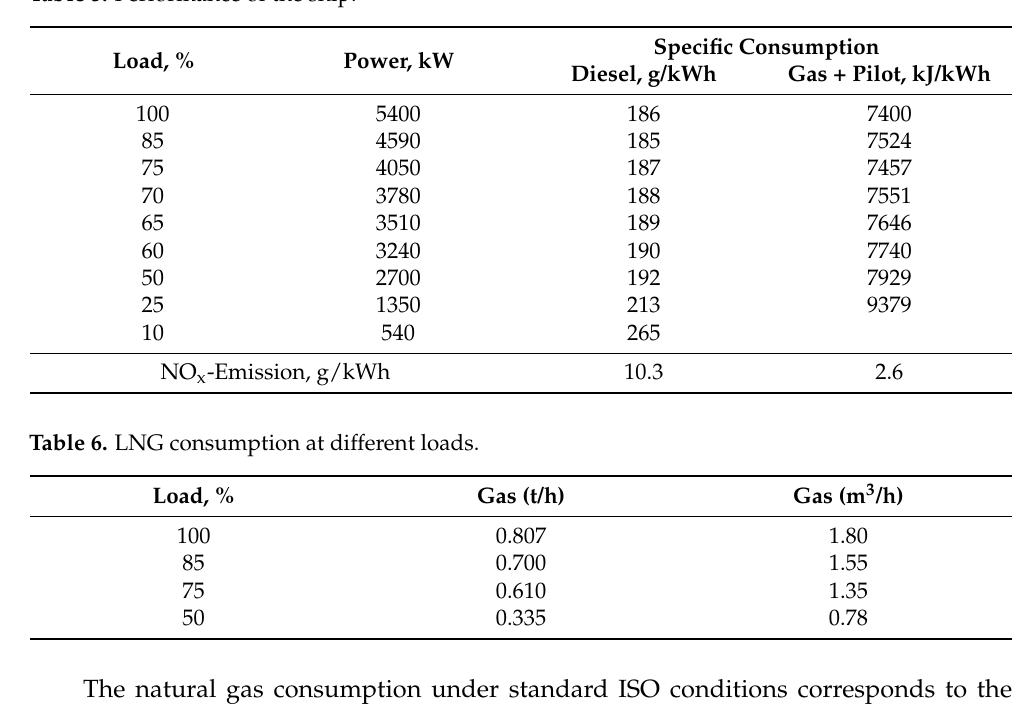
Table 5. Performance of the ship.